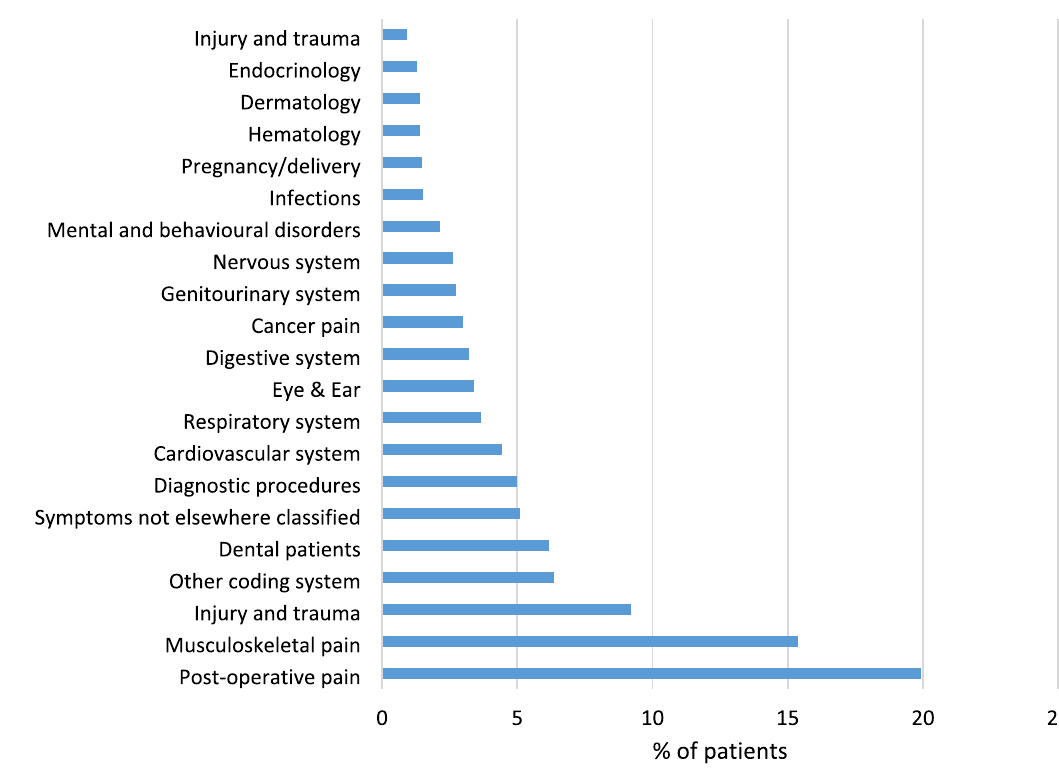
Figure 3. Indication for opioid initiation based on diagnostic coding for the most recent health care visit prior to the first dispensed opioid prescription. All percentages in the figure are proportions of the total patient cohort of 1,761,584 opioid